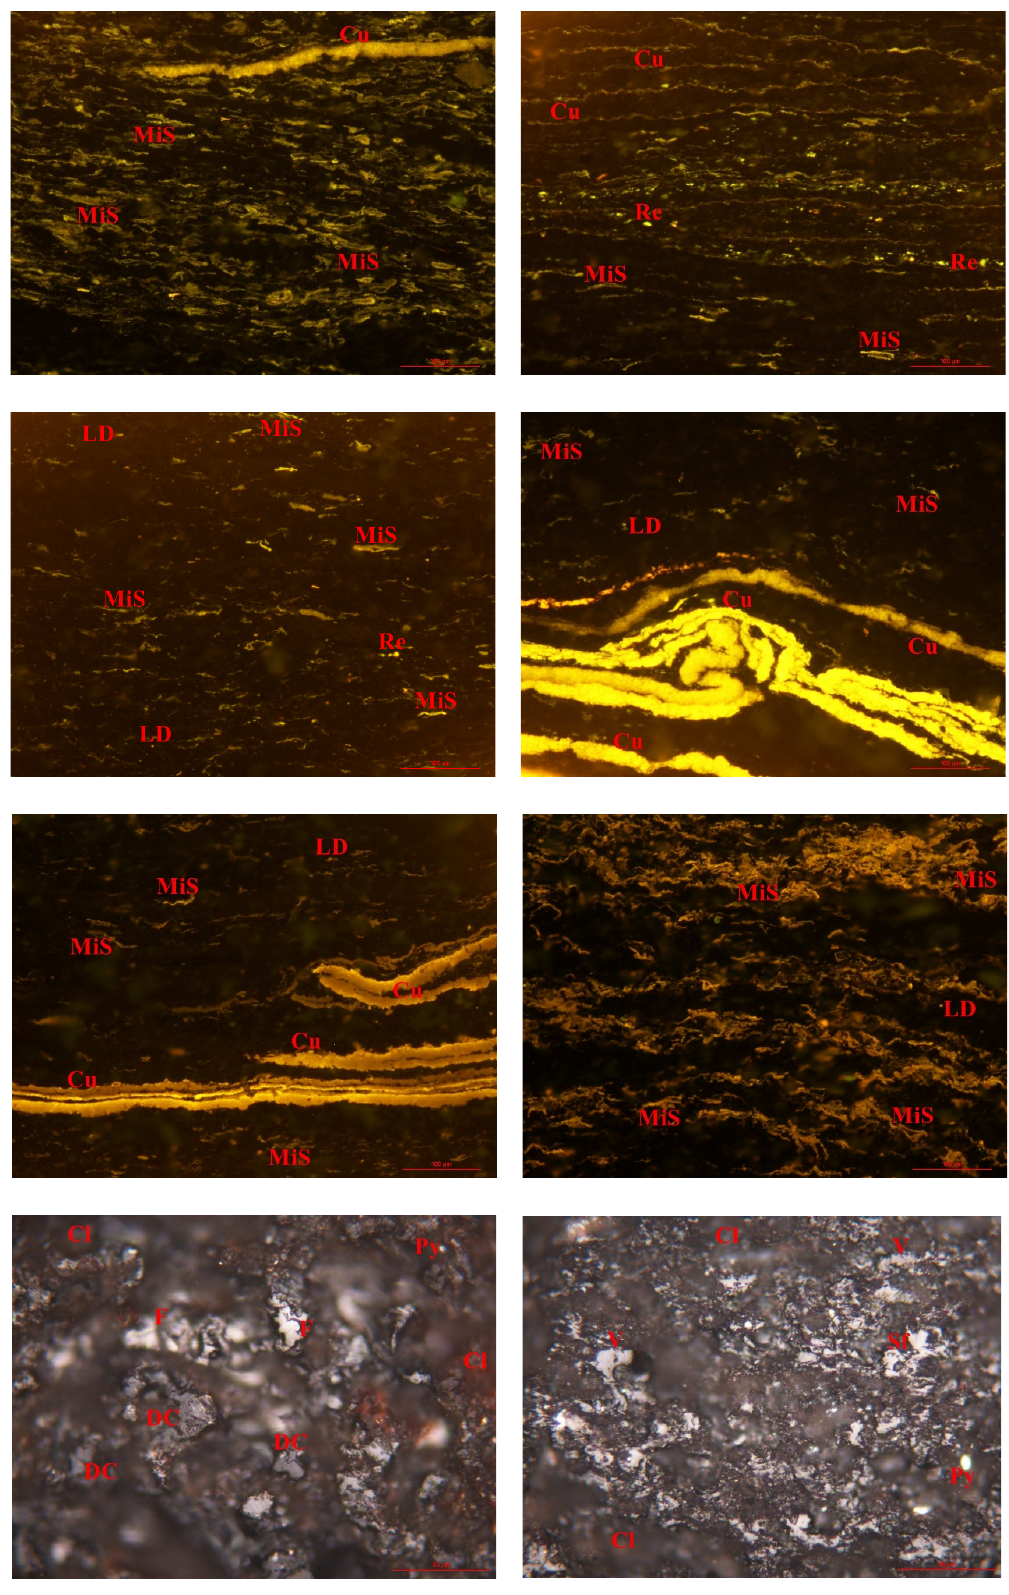
Figure 3. Characteristic macerals from Baode coals, polished section, reflected fluorescence and re- flected plane-polarized light (last two pictures). Cu: cutinite; MiS: microsporinite; DC: desmocollinite; F: fusinite; Sf: Semifusinite; Py: Pyrite; V: Vitrinite; Cl: clay; Re: resinite; LD: liptodetrinite.